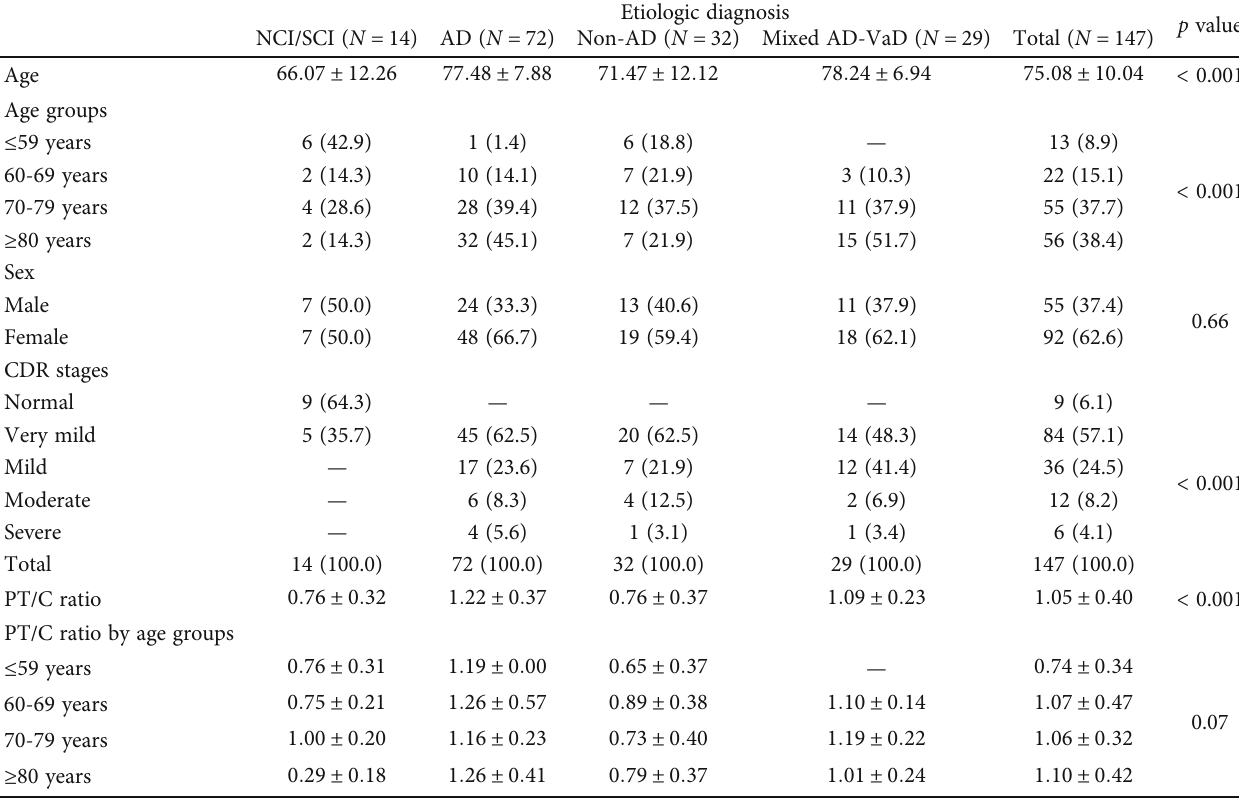
Table 1: Clinical characteristics of participants. Etiologic diagnosis